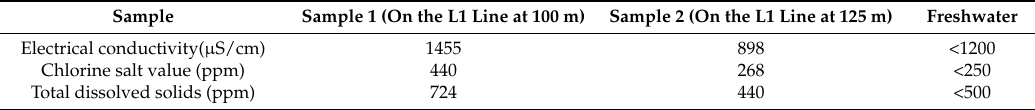
Table 3. Water quality sampling